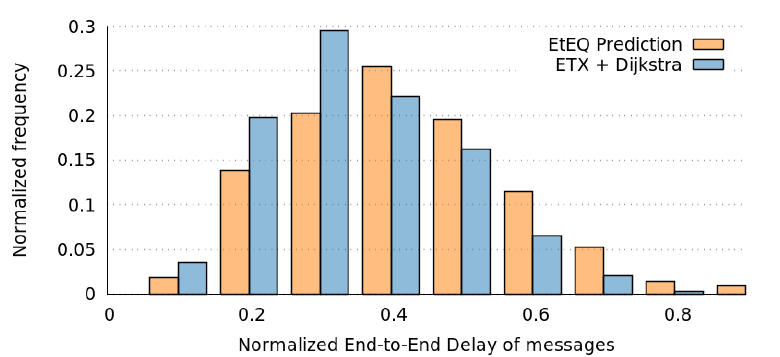
Figure 23. Histogram of end-to-end